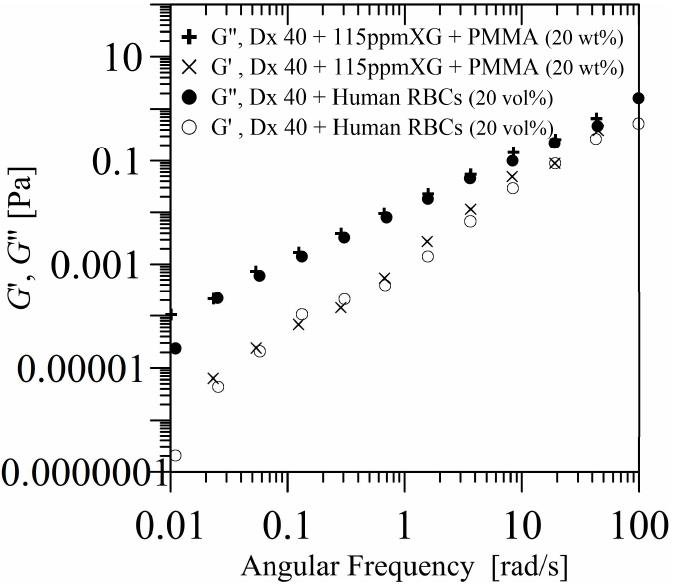
Figure 7. SAOS measurement of the storage ( G (cid:48) ) and loss ( G (cid:48)(cid:48) ) moduli for a solution of PMMA of 20 wt% suspended in Dx40 and 115 ppm XG, and a solution of healthy RBCs of 20 vol% suspended Figure 7: The SAOS measurement of the storage (G`) and loss (G”) moduli for a solution of PMMA of 20 wt% suspended in Dx40 and 115ppm XG, in Dx40 and a solution of healthy RBCs of 20 vol% suspended in Dx40 [54] .